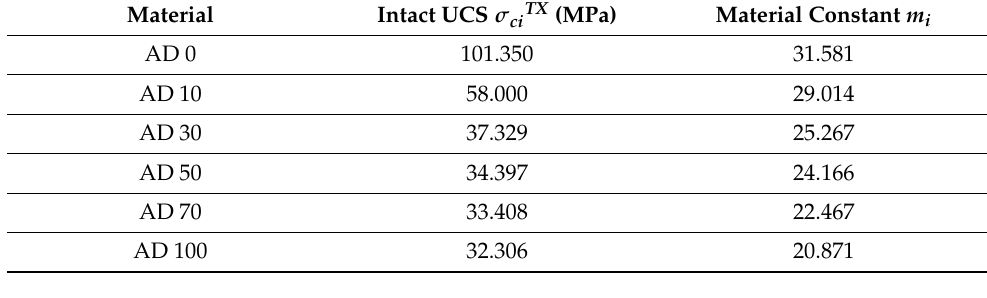
Table 3. Strength parameters of Hoek–Brown failure criterion.